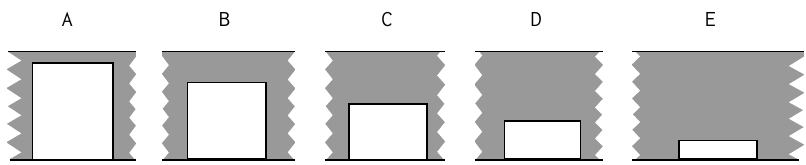
Fig. 7. Scheme of the damages at different depth in the numerical simulation.